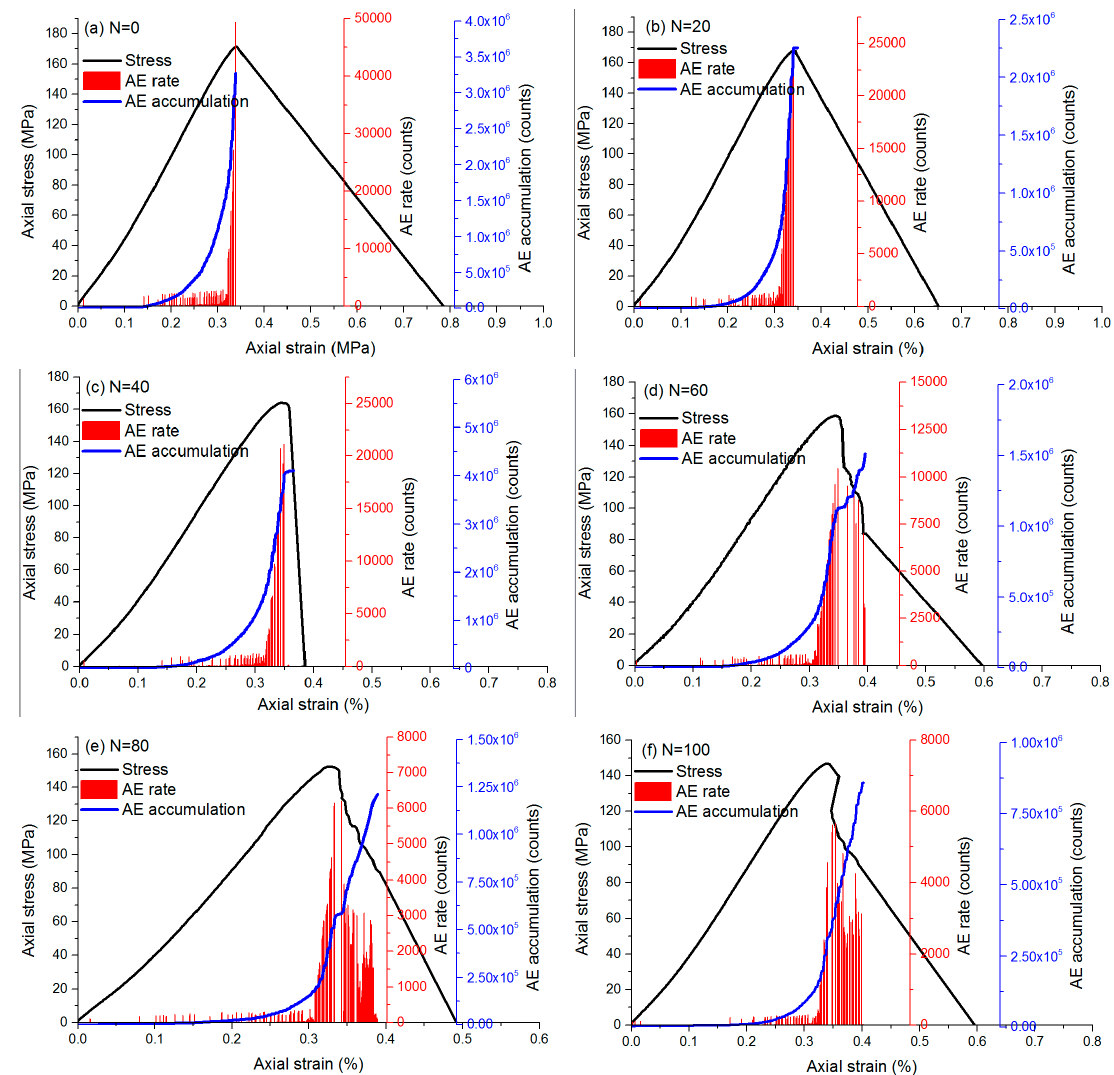
Figure 16. The AE counts for the granite samples experiencing different F–T cycles. ( a – f ) AE counts for marble samples subjected to 0, 20, 40, 60, 80 and 100 F–T cycles.